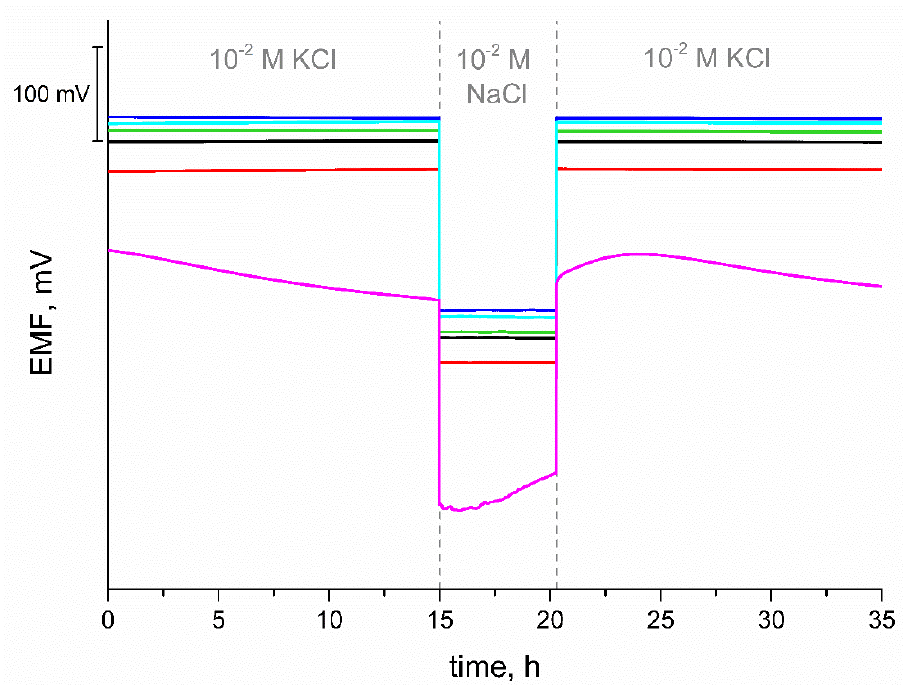
Figure 6. Water layer test of GC/eCNF/K + ‐ ISM (blue), GC/eCNF ‐ Co/K + ‐ ISM (cyan), GC/eCNF/CNT[HD] ‐ Co/K + ‐ ISM (green), GC/eCNF/CNT[HD] ‐ NiCo/K + ‐ ISM (black), GC/eCNF/CNT[LD] ‐ NiCo/K + ‐ ISM (red) and coated disc electrode (magenta).